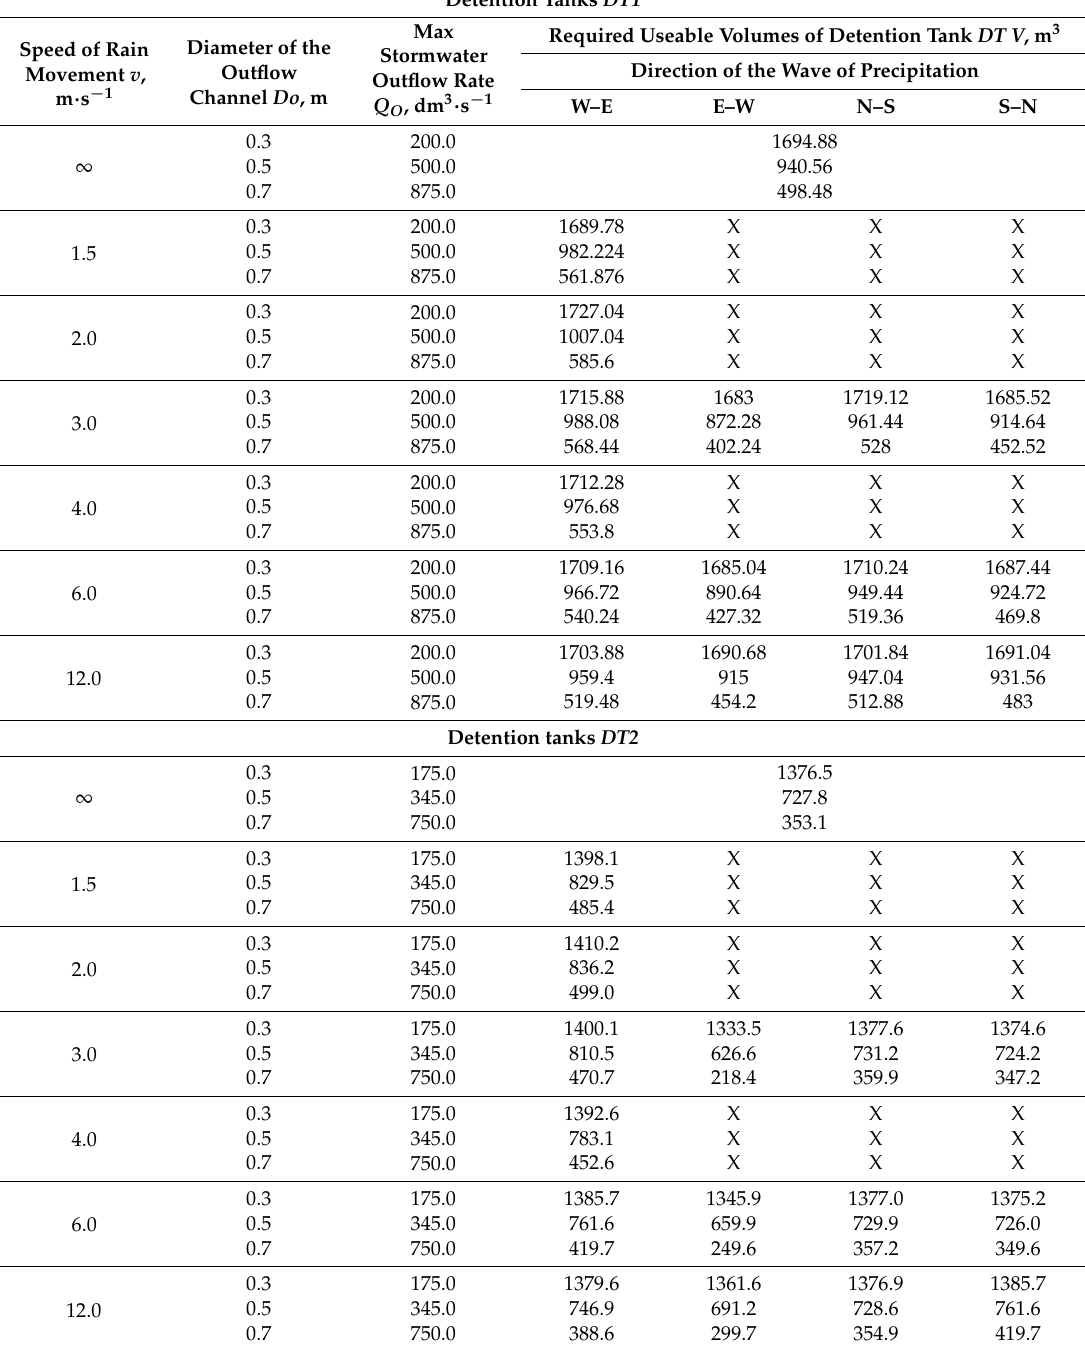
Table 2. Required volumes of detention tanks DT1 and DT2 determined at the specific diameters of the outflow channels Do